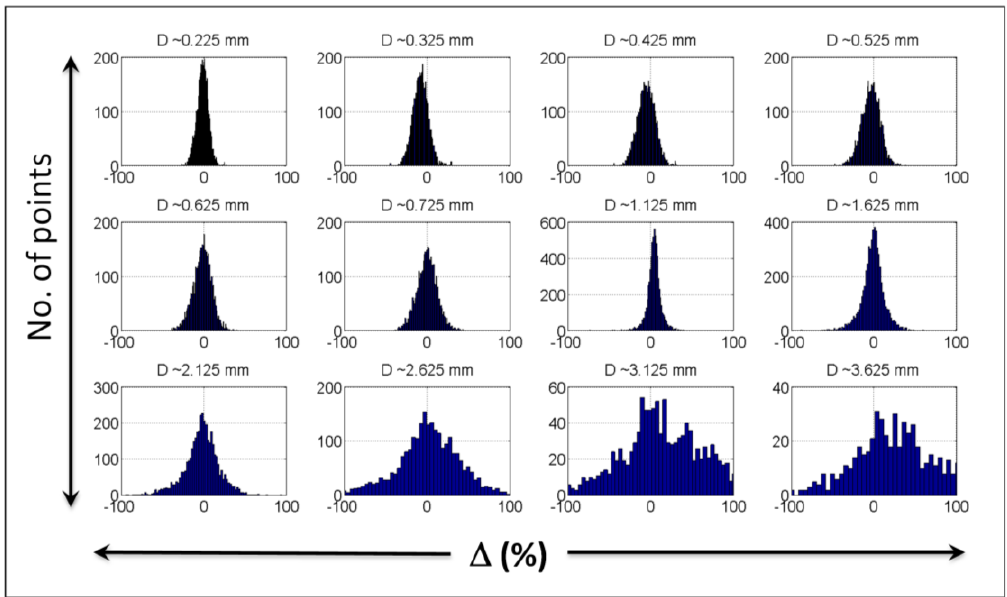
Figure 4. Histograms of the relative deviation (in %) between the measurements and the GG fits for selected drop diameter intervals. The center diameter is on top of each panel.